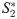
Effects of protein overexpression on total protein in single-substrate and multiple-substrate models.(A) There is a non-linear transition in the [S]T vs. Q curve when Q is comparable in magnitude with the measure of saturation (in this case, [M]). The slope of the curve approaches 1 on either side of the transition, which is consistent with the maximum and minimum values of [S]T. (B) Schematic diagram for multiple substrates with one modification state each. Shown here is the model corresponding to two substrates, for simplicity. Here “M” denotes modifying enzyme and “D” denotes demodifying enzyme. Modified substrate is indicated by the dark, filled circle. (C) Plot of total concentration of first substrate vs. synthesis rate of the second substrate, for the multiple-substrate analogs of the Full model and the representative multiple modification state model. Axes are on a log scale. (D) Sensitivity to signal for first substrate vs. synthesis rate of the second substrate, for the multiple-substrate analogue of the Full model. The semi-analytical curve was obtained by substituting values for S2* obtained empirically from simulation into α2 in the analytical expression for r50 ([S1]T). Axes are on a log scale.